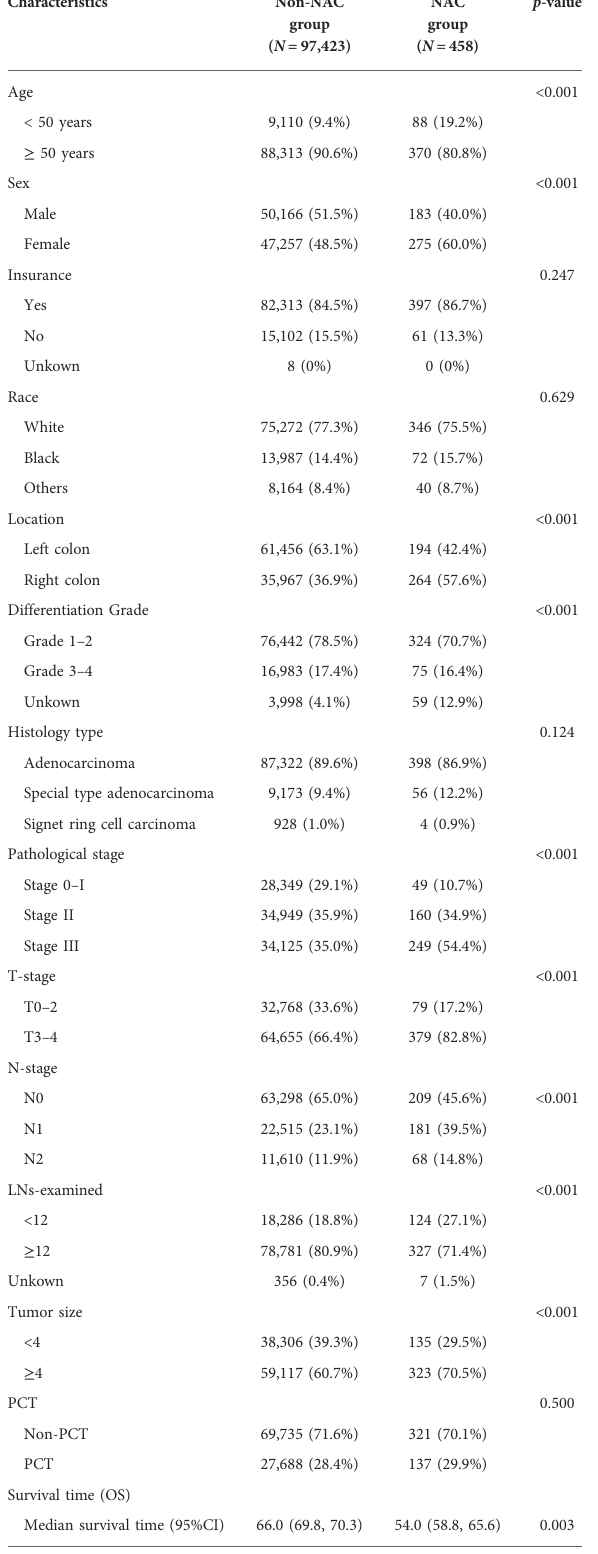
TABLE 1 Patient characteristics ( N =97,881).